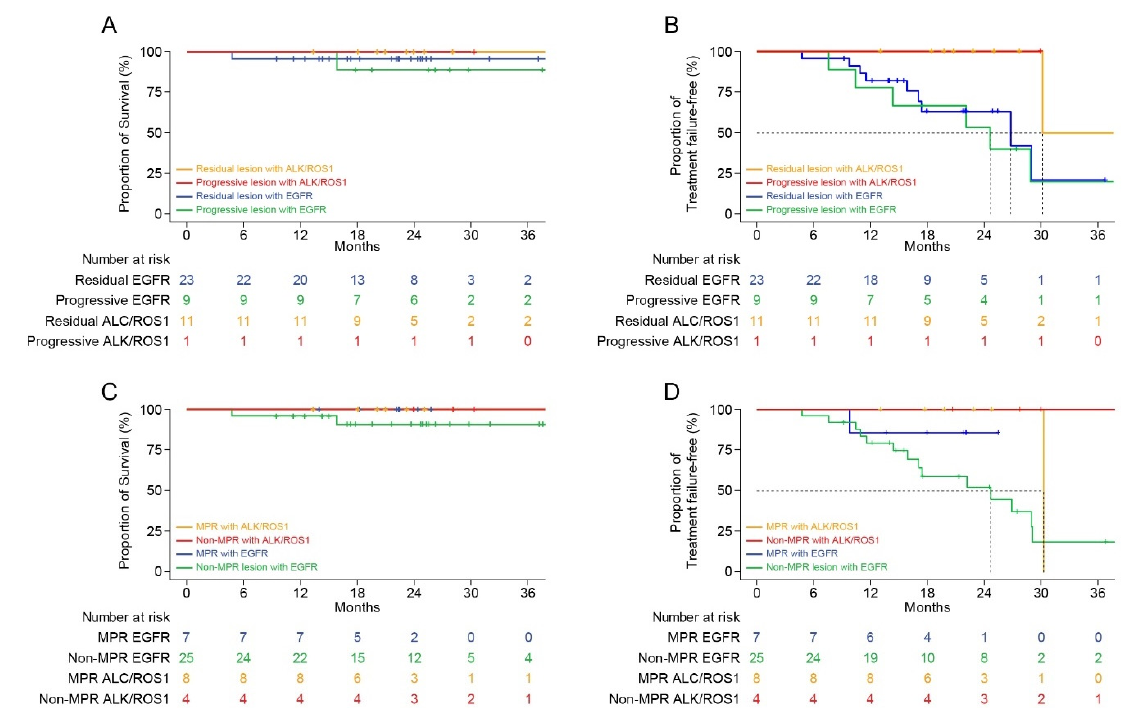
Figure 5. Kaplan–Meier survival curves according to the intent of surgery and pathologic response at the primary lesion. ( A ) Overall survival according to the intent of surgery after using the targeted agent immediately before surgery. ( B ) Treatment failure-free survival according to the intent of surgery after using the targeted agent immediately before surgery. ( C ) Overall survival according to the pathologic response at the primary lesion after using the targeted agent immediately before surgery. ( D ) Treatment failure-free survival according to the pathologic response at the primary lesion after using the targeted agent immediately before surgery.